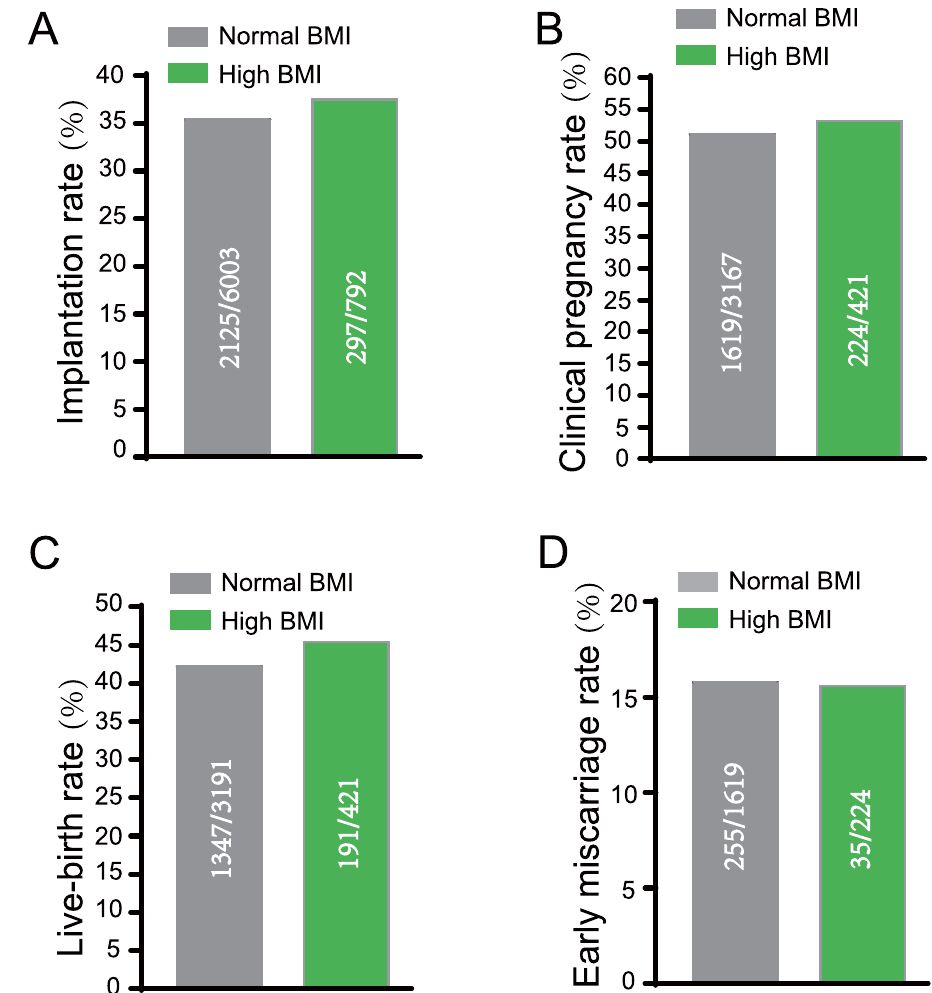
Figure 1. The normal BMI and high BMI groups did not have difference in the implantation rate ( A ), clinical pregnancy rate ( B ), live-birth rate ( C ) and early miscarriage rate ( D ) after FET. The raw data were shown